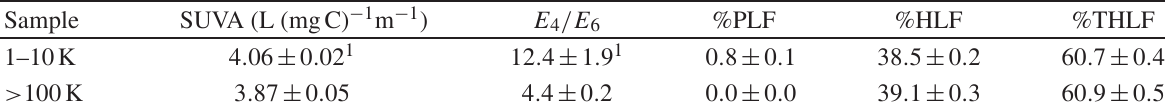
TABLE 1: Specific UV absorbance (SUVA) values and fluorescence distributions for the two different size fractions of a soil humic acid and the mixture.